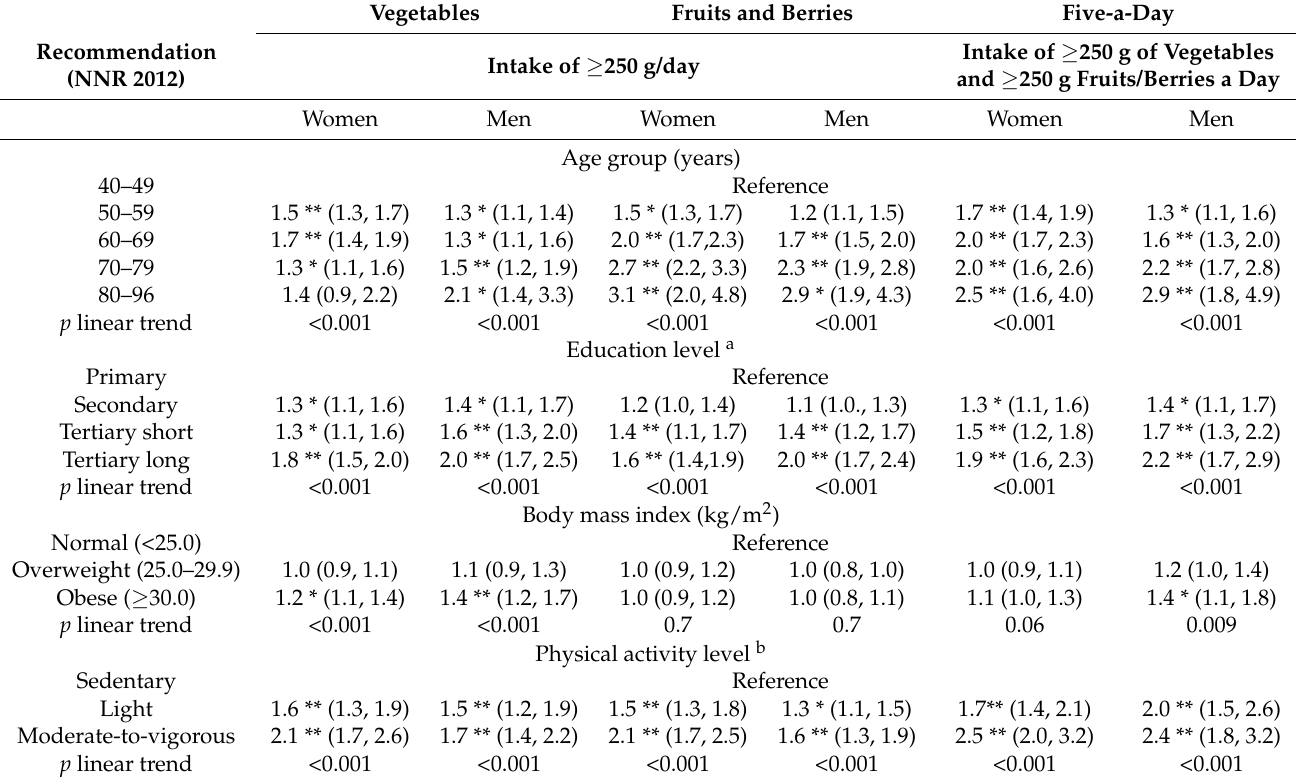
Table 5. Logistic regression analysis of odds of being compliant with recommendations. The Tromsø Study 2015–2016. Vegetables Fruits and